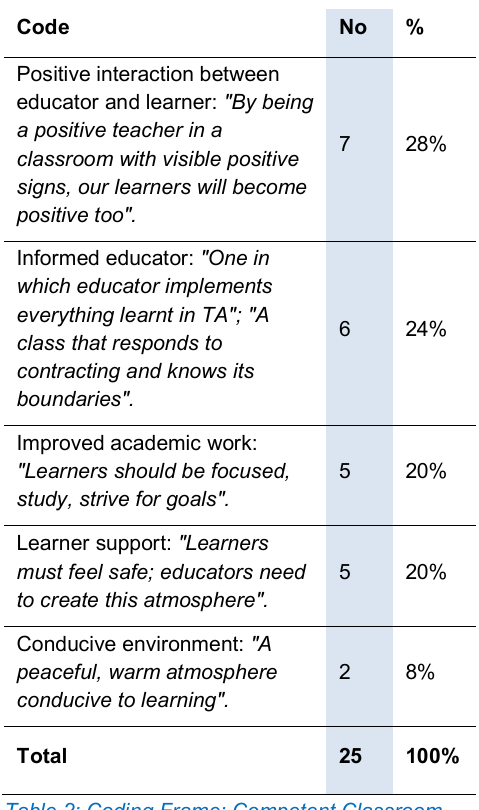
Table 2: Coding Frame: Competent Classroom, Post-TA